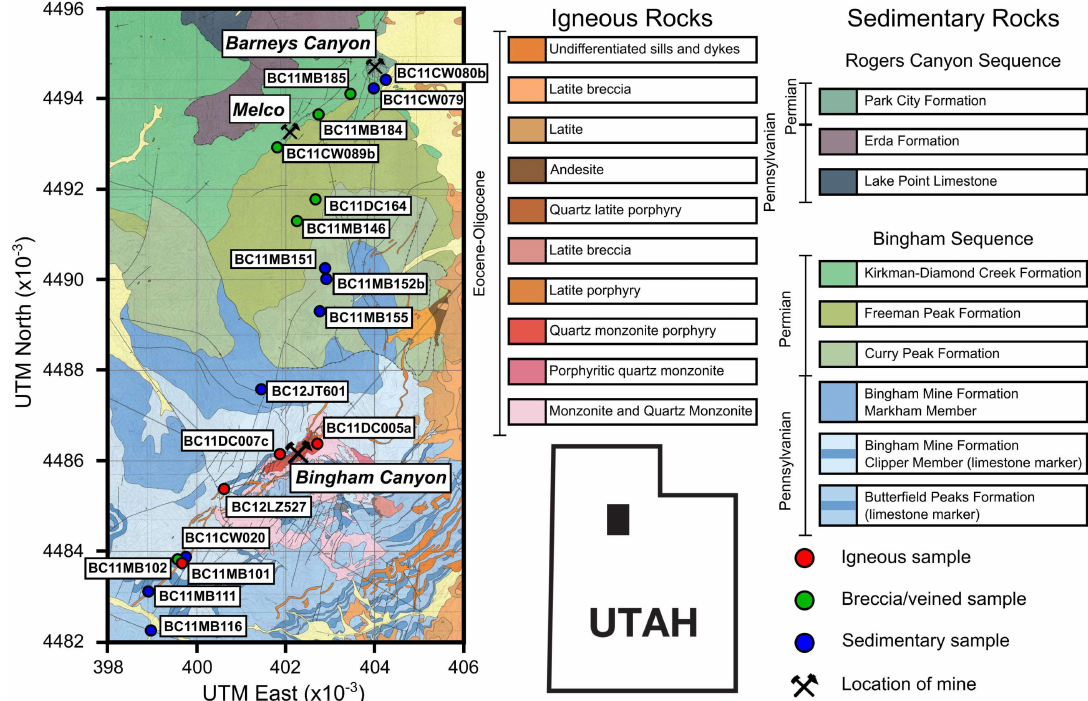
Figure 1. Geological map of the area surrounding the Bingham Canyon porphyry Cu deposit; all samples analysed for Tl isotope compositions are marked with sample name and lithology; inset map of Utah showing study area (black rectangle), modified after